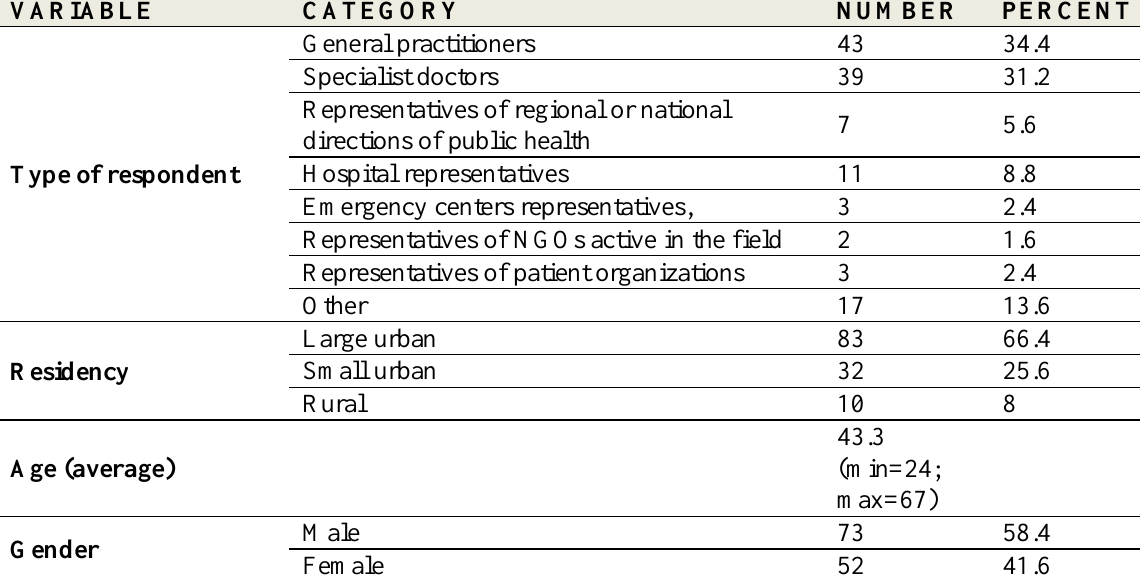
Table 2. Demographic characteristic of knowledgeable observers